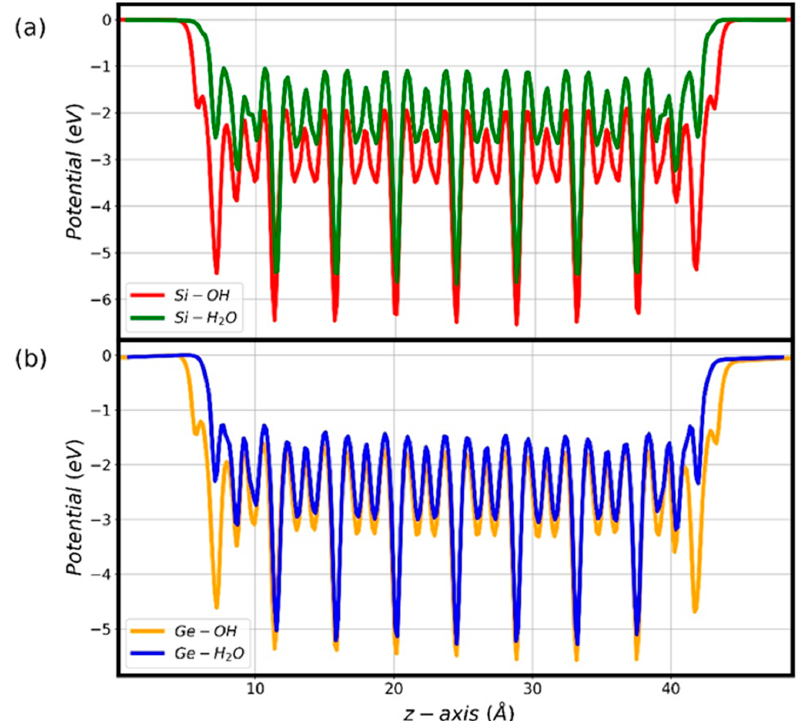
Figure 8. Radially averaged PBE0-TC-LRC electrostatic potential along the hex-7 AlSi ( a ) and AlGe ( b ) NT (z) axis as a function of the OH or H 2 O termination.